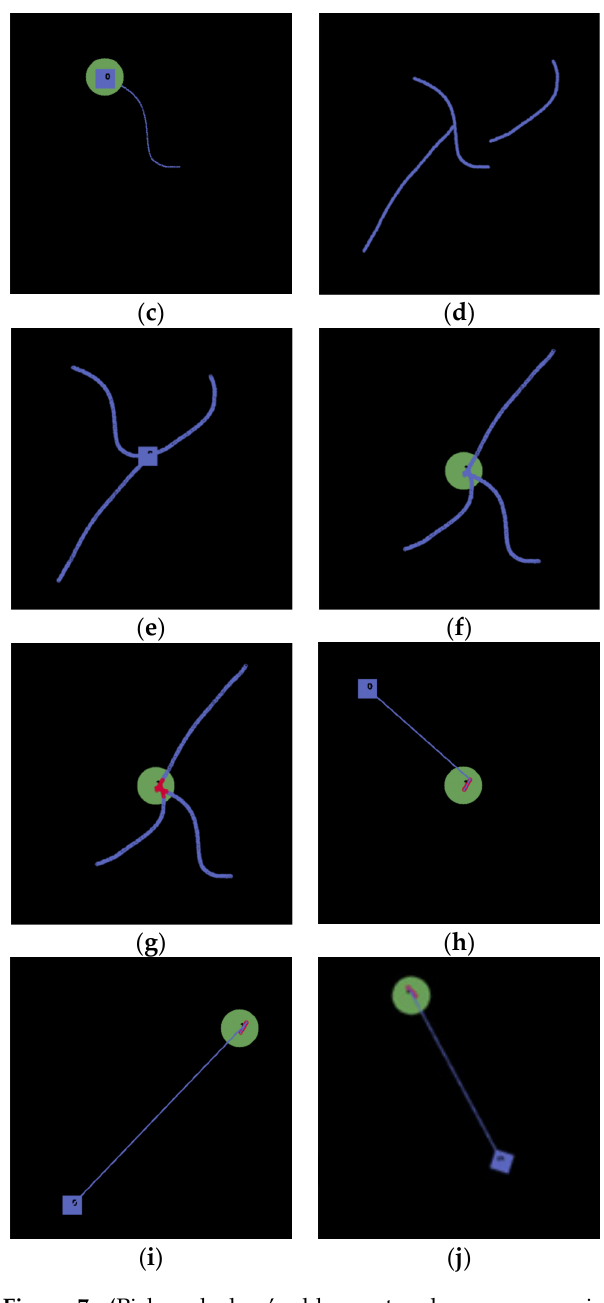
Figure 7. ‘Pick and place’ a blue rectangle on a green circle. ( a ) The first demonstration path. ( b ) The second demonstration path. ( c ) The third demonstration path. ( d ) Absolute trajectory (type-1) through three demonstrations. ( e ) Relative trajectory (type-2) through three demonstrations. ( f ) Relative trajectory (type-3) through three demonstrations. ( g ) Key path of the relative trajectory (type-3). ( h – j ) Planned path based on the key path.